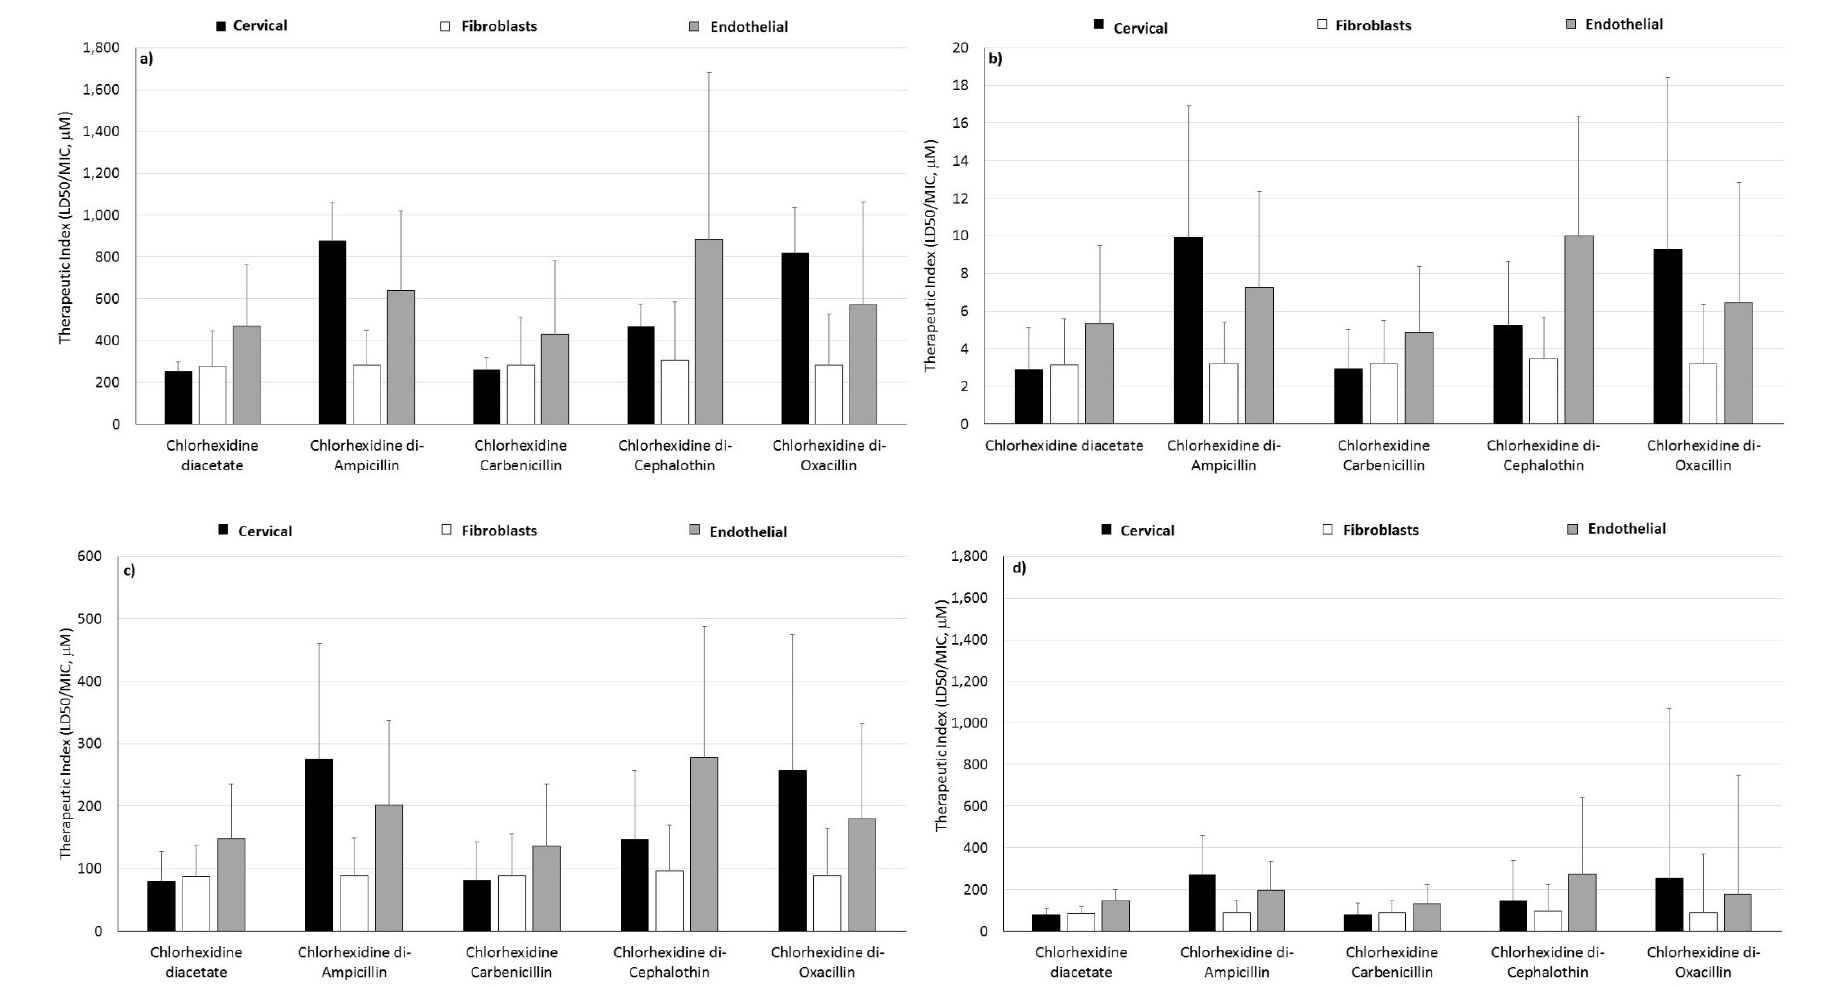
Figure 4. Theoretical therapeutic indices of β-lactam-based chlorhexidine GUMBOS determined from ( a ) drug-susceptible Gram-negative bacteria, ( b ) multi-drug-resistant Gram-negative bacteria, ( c ) drug-susceptible Gram-positive bacteria and ( d ) MRSA , against cervical, fibroblasts and endothelial cell